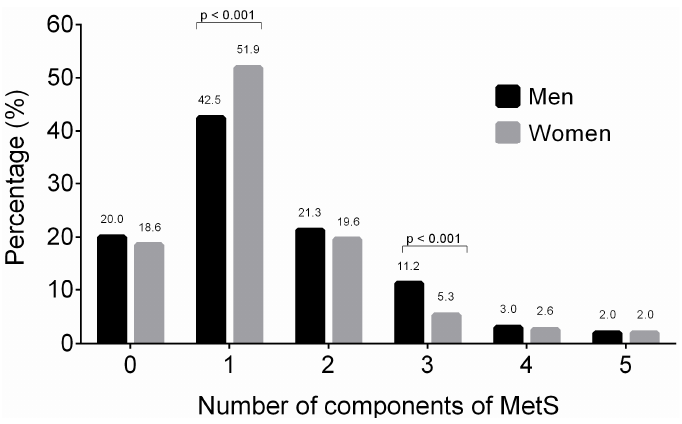
Figure 1. Distribution of the prevalence of metabolic syndrome components according to sex.